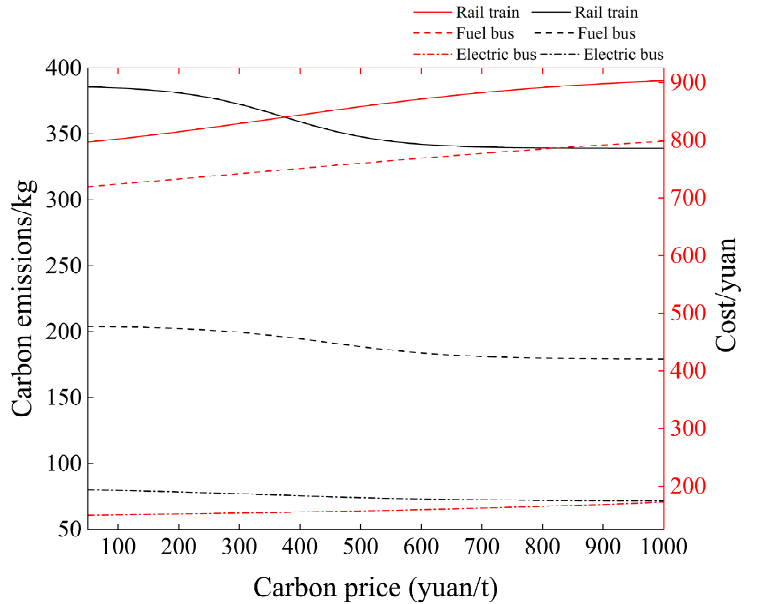
Figure 5. Changes in carbon emissions and costs of urban public transport vehicles at different carbon prices.